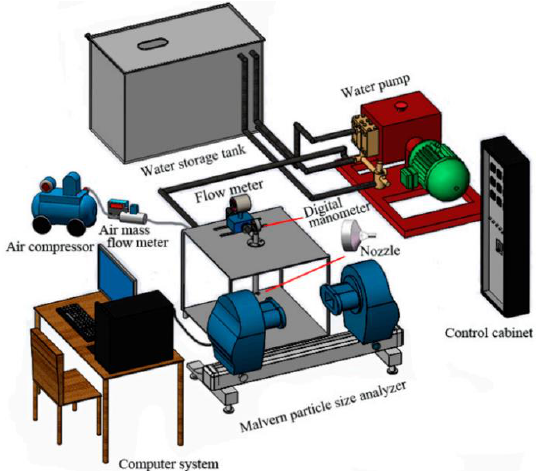
Figure 4. The experimental platform proposed by Li et al. [10].